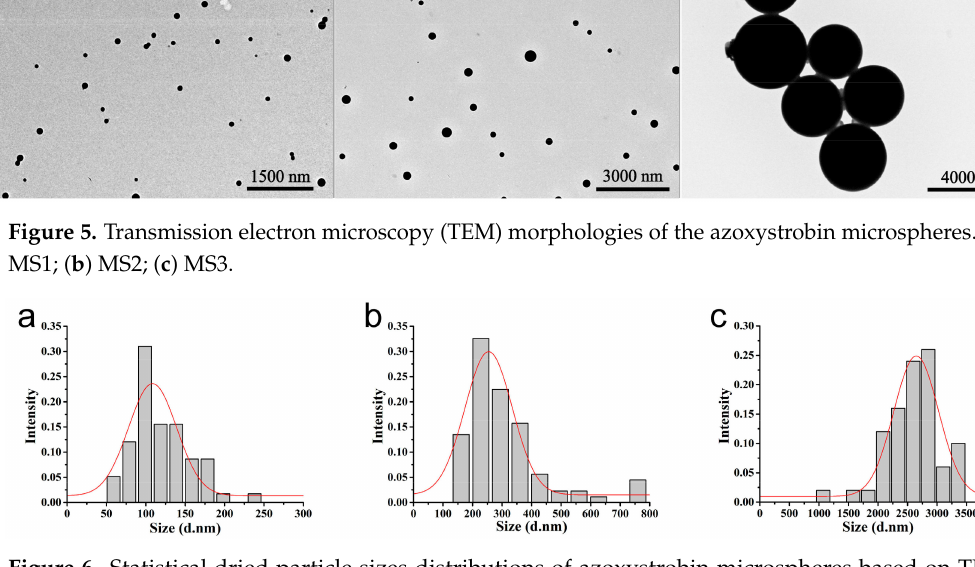
Figure 6. Statistical dried particle sizes distributions of azoxystrobin microspheres based on TEM images. ( a ) MS1; ( b ) MS2; ( c )